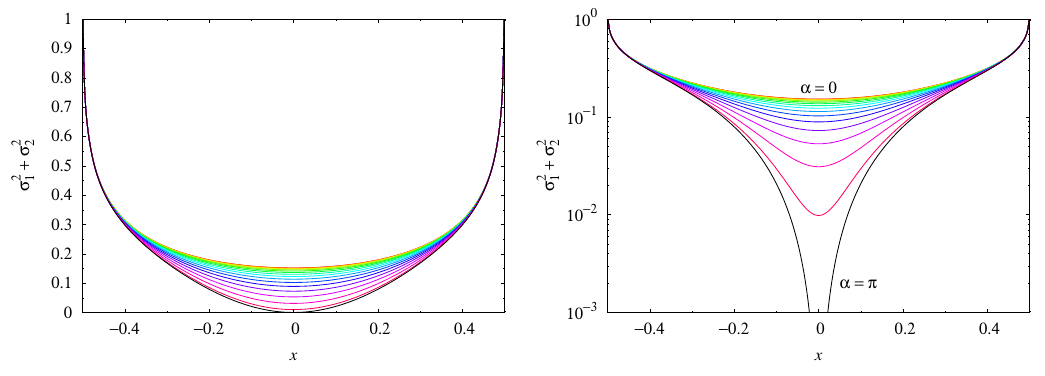
Figure 12. The same as (cid:12)gure 3 but for L = 1.